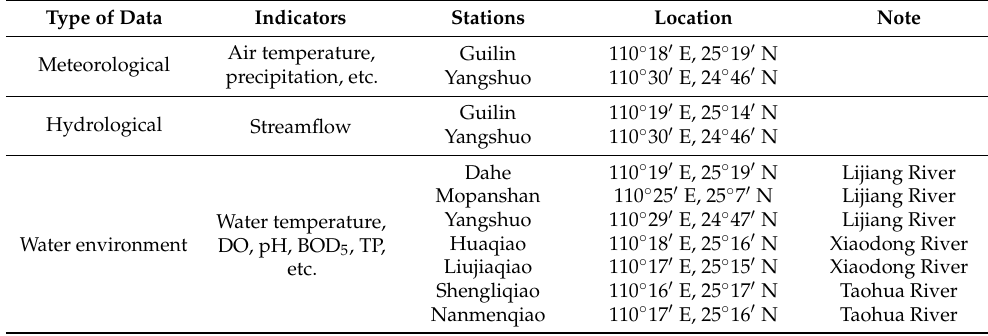
Table 1. Information on monitoring stations.